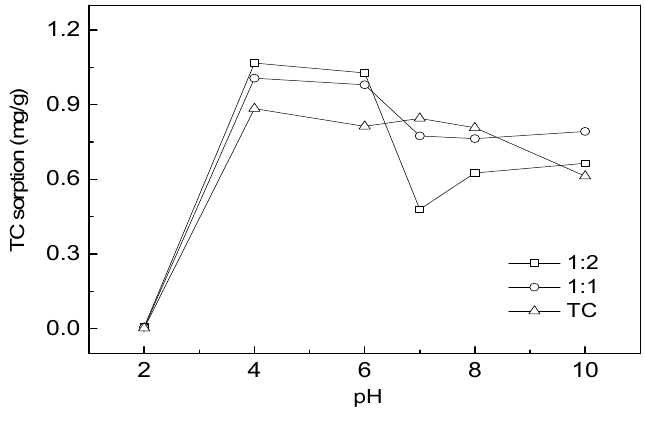
Figure 9. Effect of pH on TC adsorption onto water hyacinth root in the presence or absence of Cu.